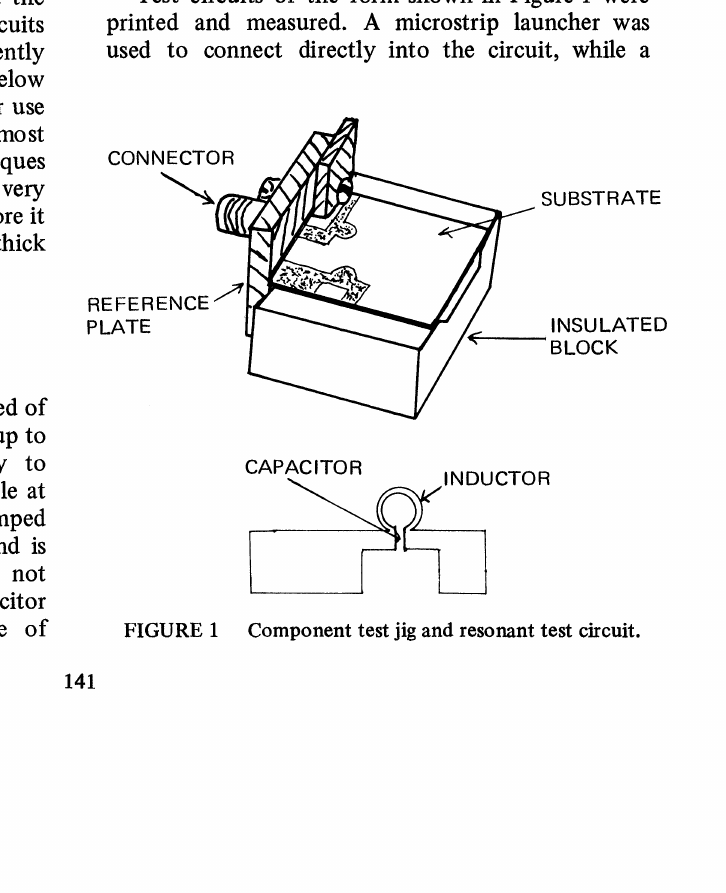
FIGURE 1 Component test jig and resonant test